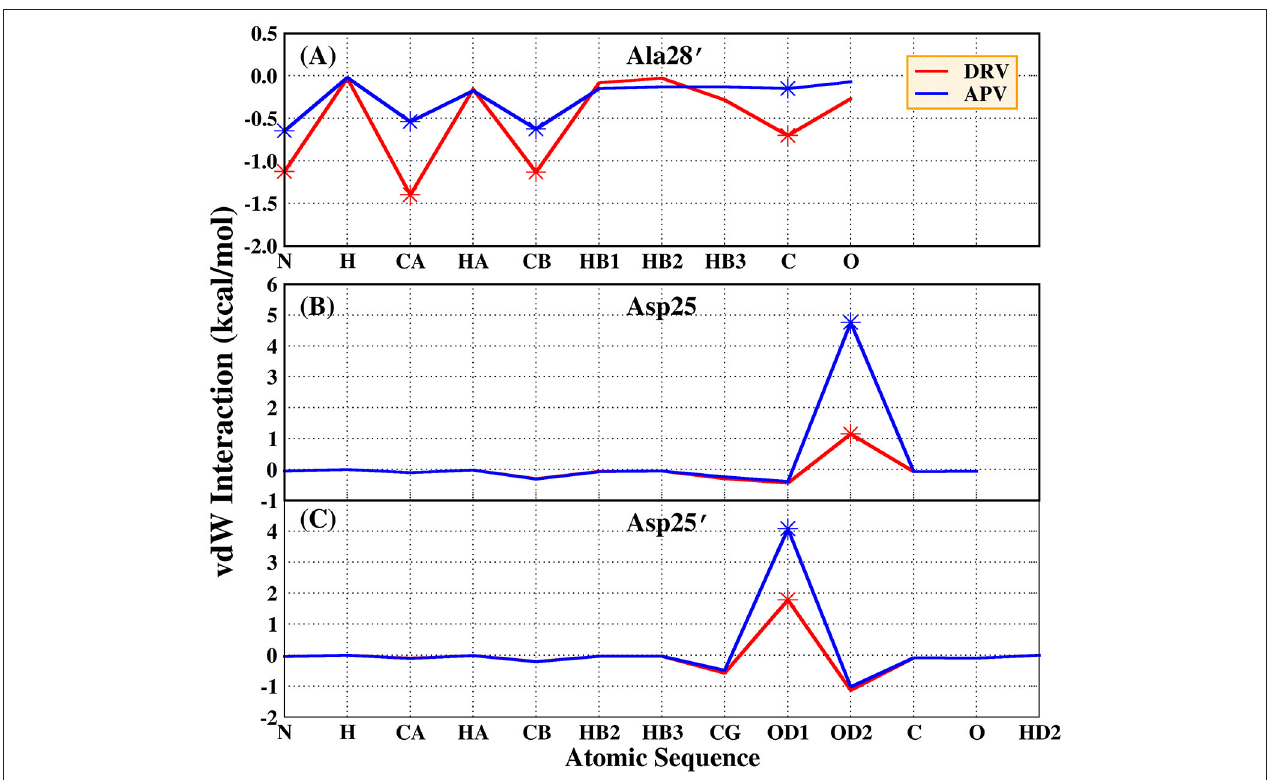
FIGURE 6 | vdW interaction of per atom and inhibitor in Ala28 ′ of PR1 and Asp25/Asp25 ′ of PR2. (A) Ala28 ′ residues in PR1. (B) Asp25 residue in PR2; (C) Asp25 ′ residues in